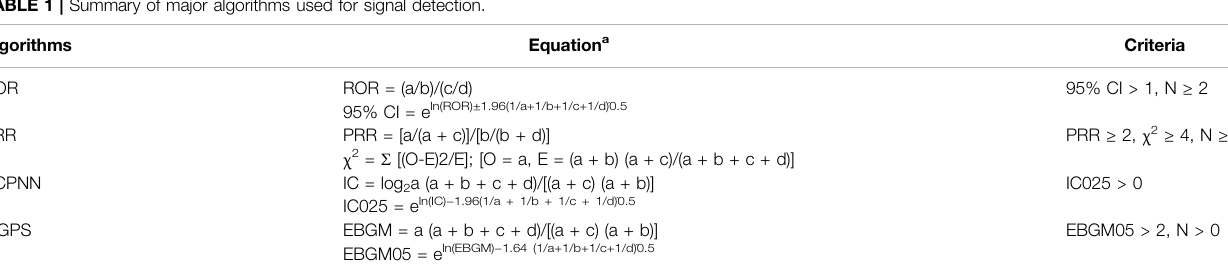
a a:numberofreportscontainingboththesuspectdrugandthesuspectadversedrugreaction.b:numberofreportscontainingthesuspectadversedrugreactionwithothermedications (except the drug of interest). c: number of reports containing the suspect drug with other adverse drug reactions (except the event of interest). d: number of reports containing other medicationsand other adversedrug reactions.Abbreviations: ROR,reporting odds ratio; CI, con fi denceinterval; N, the number of co-occurrences; PRR,proportionalreporting ratio; χ 2 , chi-squared; BCPNN, Bayesian con fi dence propagation neural network; IC, information component; IC025, the lower limit of the 95% two-sided CI of the IC; MGPS, multi-item gamma Poisson shrinker; EBGM, empirical Bayesian geometric mean; EBGM05, the lower 90% one-sided CI of EBGM.